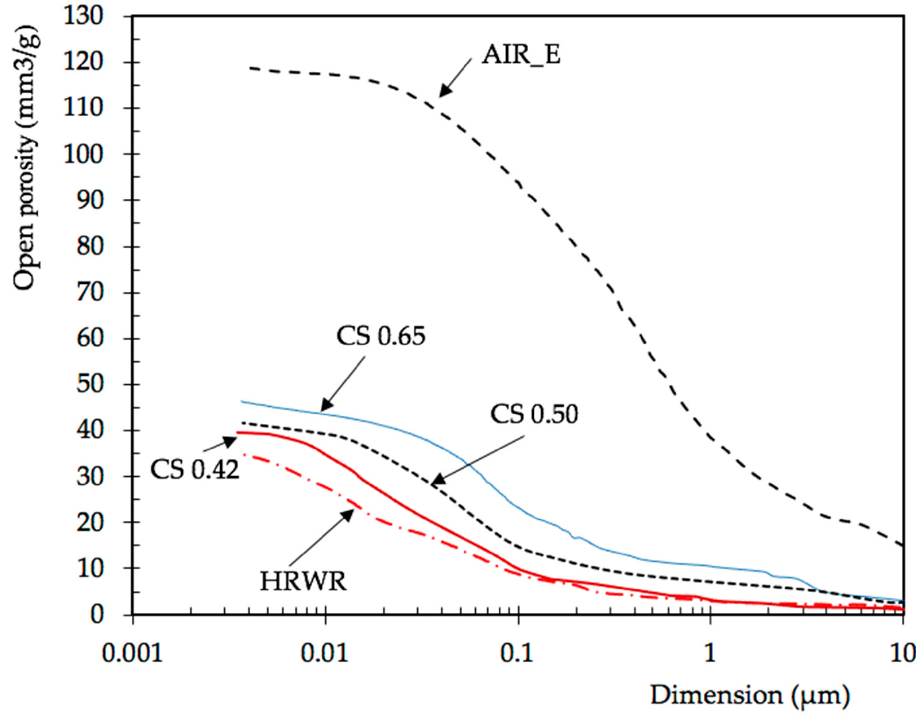
Figure 2. MIP porosity of 2B mortars cured at 90 days.